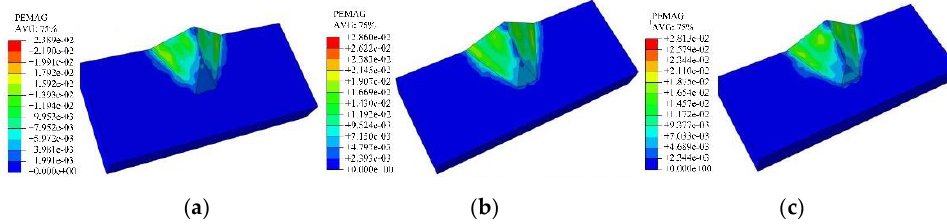
Figure 16. The plastic zone cloud map of ridge slope after excavation under different excavation slope rates. ( a ) The excavation slope ratio is 1:1.5; ( b ) the excavation slope ratio is 1:1.25; ( c ) the excavation slope ratio is 1:1.